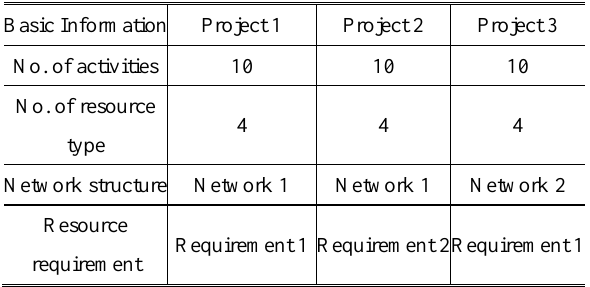
Table 1. Basic information of